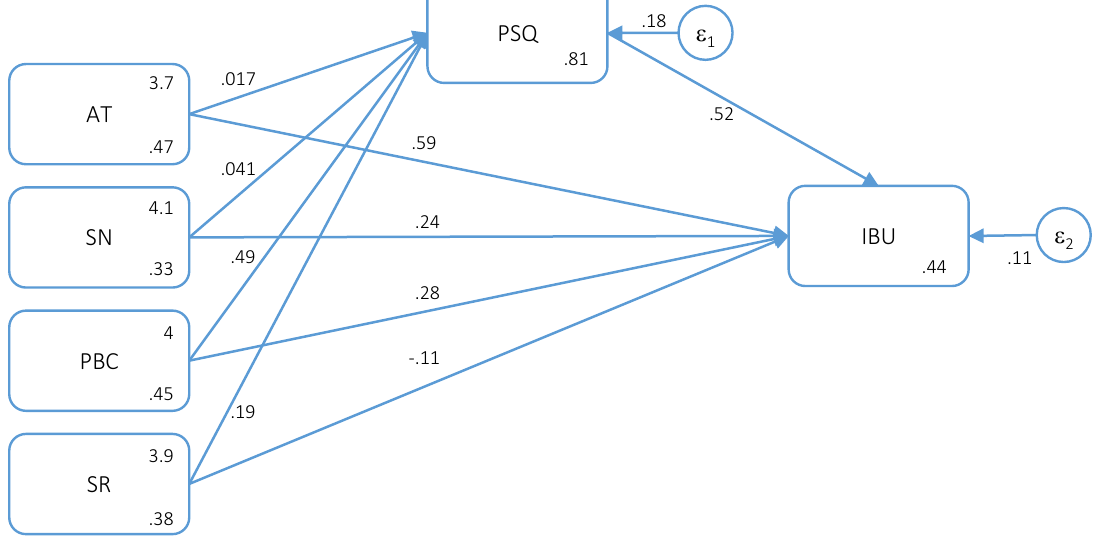
Figure 2. Structural equation